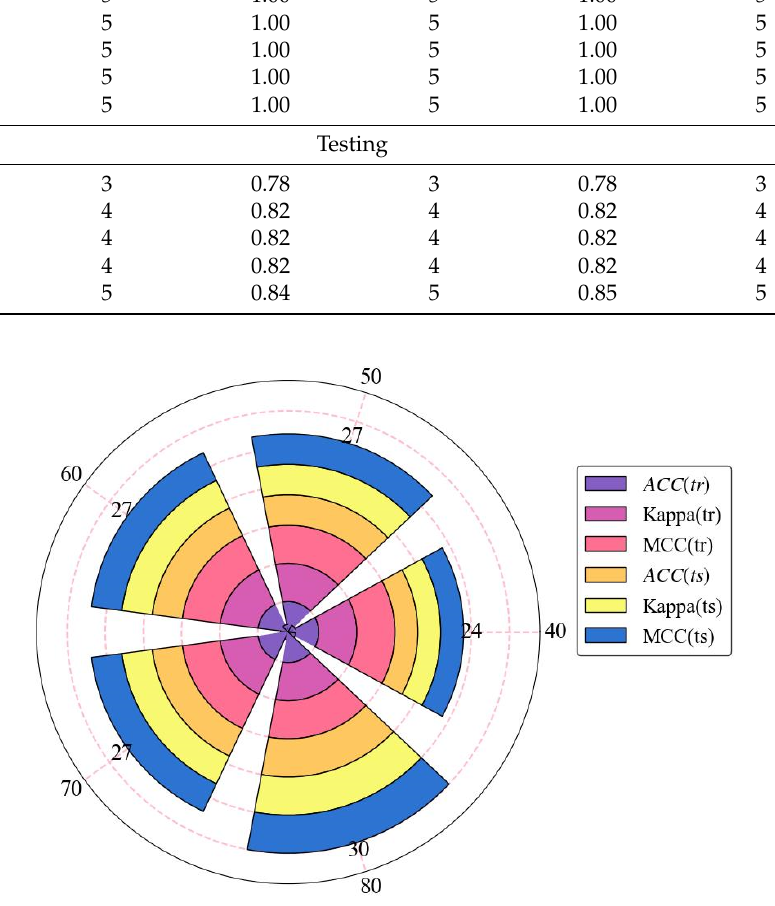
Figure 10. The final ranks of the HGS-HGBT models with different swarm sizes.